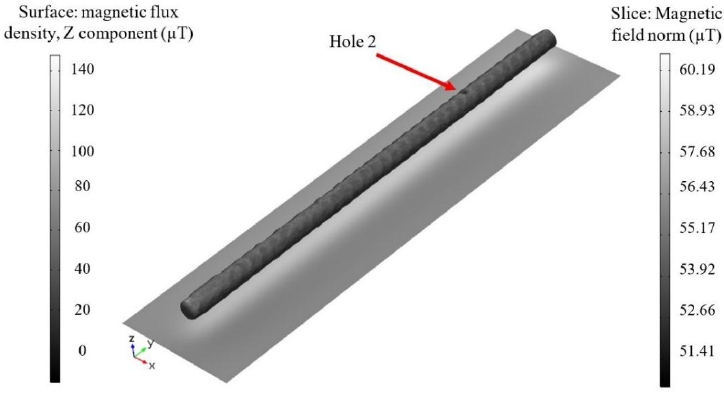
Figure 15. Behavior of Z-component magnetic flux density and normal magnetic field around the rebar (rebar mesh #8 and box mesh #5).